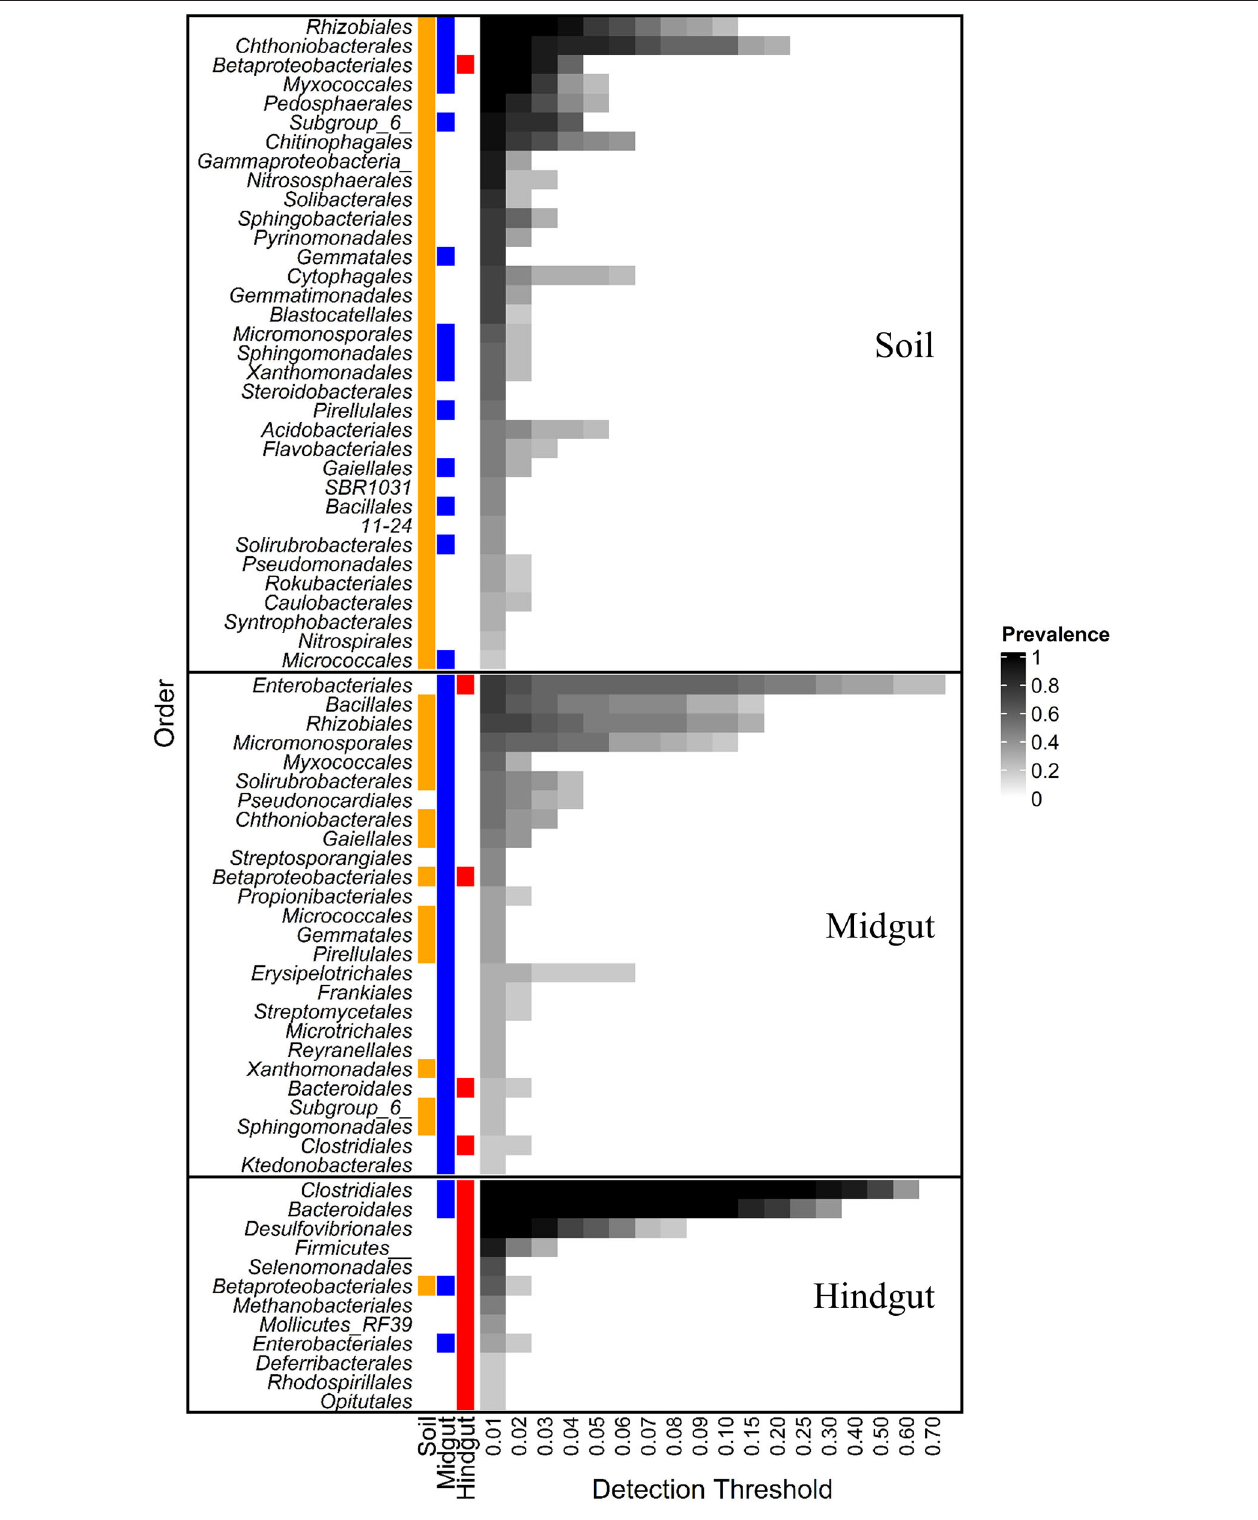
FIGURE 2 | Core prokaryotic microbiota at different detection thresholds of relative abundance across compartments: midgut and hindgut from third instar larvae of the Japanese beetle ( P. japonica ) and associated soil. Taxa at the order level with sample prevalence > 0.19 ( > 4 out of 21 samples) are presented. Colors show the presence of each taxon in different compartments at ≥ 0.01 relative abundance. Notice that Betaproteobacteriales are present in the three compartments. Taxa are presented at Order rank when available, otherwise, Class or Phylum rank are presented as indicated by Class/Phylum name followed by one or two underscore symbols, respectively. For taxonomic affiliation at Order, Class, or Phylum rank refer to Supplementary Table 3 .